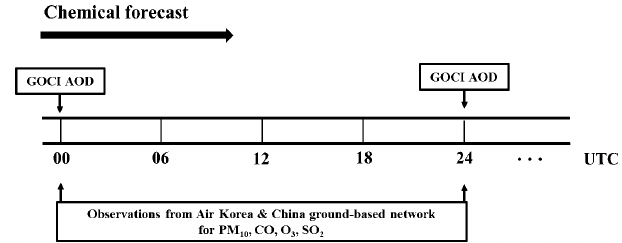
Figure 3. Schematic diagram of the Korean air quality prediction system for particulate matter (PM) and gas-phase pollutants. The data assimilation (DA) cycle is 24h for both PM and gas-phase pol- lutants such as CO, O 3 and SO 2 . The DA of NO 2 is excluded in the current study, the reason for which is discussed in the